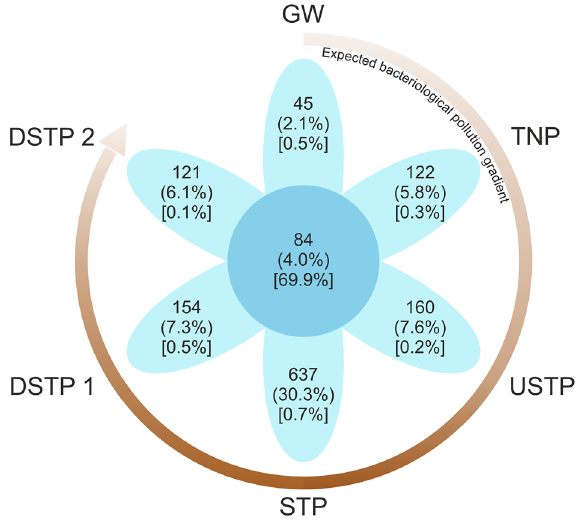
Figure 3. Venn diagram showing bacterial genera unique to and shared between the examined sites along the Białka river. Values in petals indicate from the top: numbers of genera in each group; proportions of the overall number of genera in each group (in round brackets), and proportions of 16S sequences belonging to unique genera in each group (in square brackets). Arrow graph shows the expected bacterial pollution gradient,